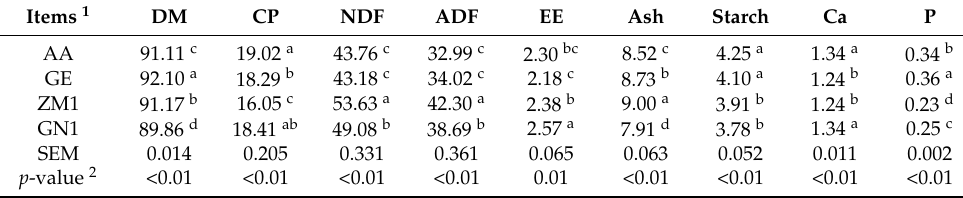
Table 3. The nutritional contents of various alfalfa hay cultivars (DM basis)